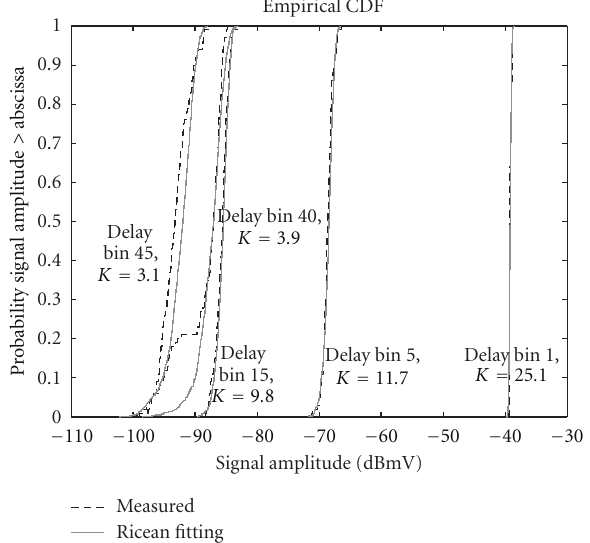
Figure 14: CDFs of the amplitudes of five delay bins, 1, 5, 15, 40 and 45 with corresponding K factors for LOS case at Rx12.